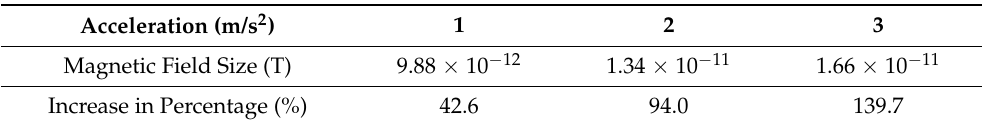
Table 5. Wake magnetic field size and increase percentage under different accelerations in 3.5 s of